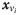
The structure of the forward RNN for each observed variant with residual connections for the case of four stacked RNN cells.xvi and xvi+1 are input feature vectors for observed variants vi and vi+1, respectively. si,j(f) is the state of the RNN cell of the jth layer for observed variant vi and used as the input of the state for the RNN cell of the jth layer for observed variant vi+1. Circles with + represent the addition of tensors for residual connections. The output of the RNN cell of the top layer, oi,4, is handled as the output of RNN for each observed variant.